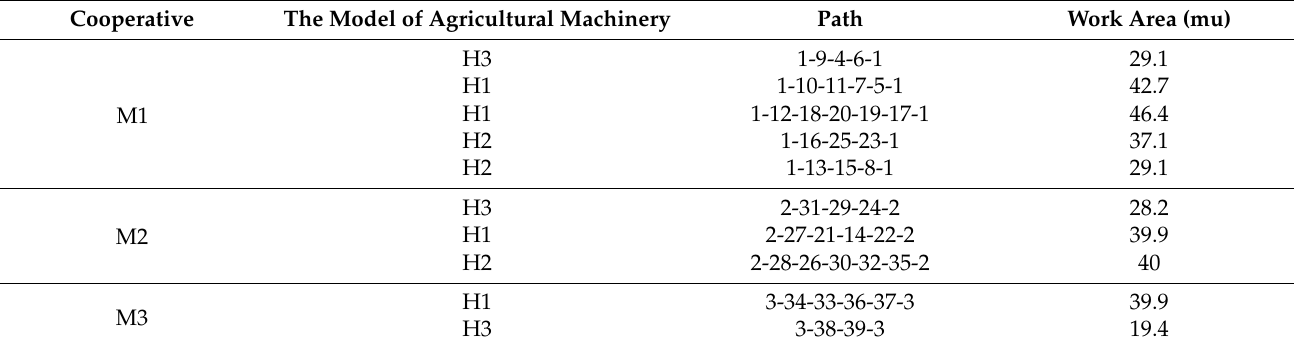
Table 7. The first stage agricultural machinery scheduling path